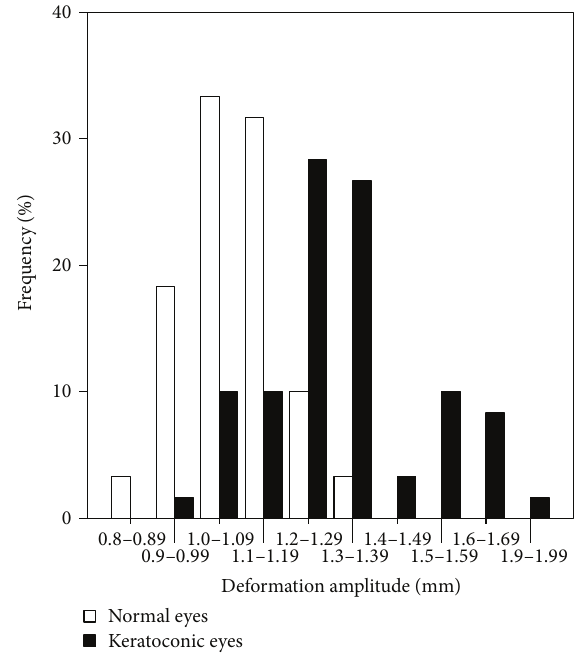
Figure 4: Histogram of DA for keratoconic and normal eyes.